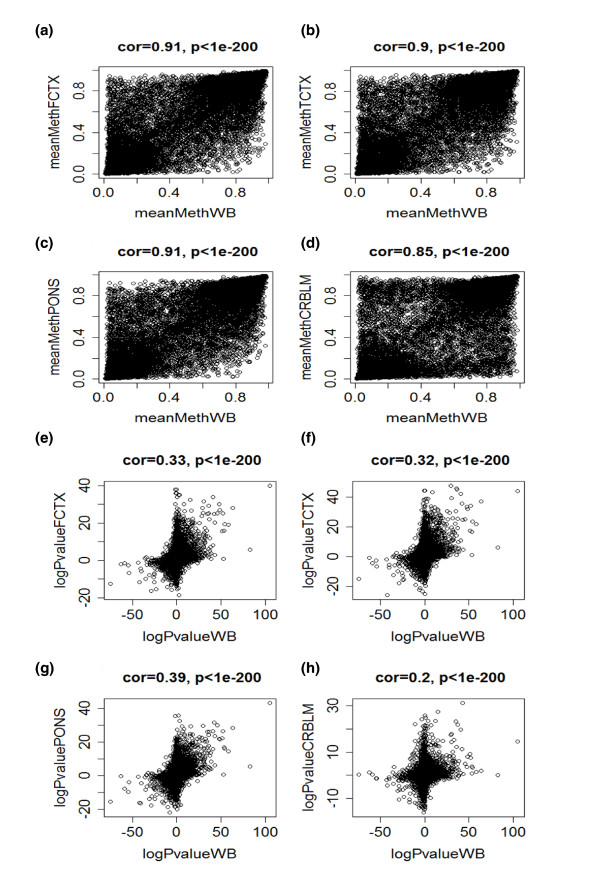
Age effects on DNA methylation levels are well preserved between blood and brain tissue. (a-d) Scatterplots of mean CpG methylation levels in whole blood of the Dutch samples (x-axis) and corresponding mean brain methylation values (y-axis) for frontal cortex (FCTX) (a), temporal cortex (TCTX) (b), pons (c), and cerebellum (CRBLM) (d). The brain methylation data used were obtained from [19]. Note that strong correlations (around r = 0.9) exist between the mean methylation levels in whole blood and brain tissue. We hypothesize that the relatively low correlation of r = 0.85 for cerebellum may reflect DNA quality. (e-g) Age correlations of CpG methylation levels show moderate preservation (correlations around 0.33) between blood (x-axis) and brain tissues (y axes). Analogous to Figure 1, the methylation levels of each gene (represented by a dot) were correlated with subject age and a linear regression model was used to calculate a correlation test P-value. The x-axis of each scatterplot shows the (signed) logarithm (base 10) of the correlation test P-value in blood. Genes with a significant positive (negative) correlation with age have a high positive (negative) log P-value. The y-axis shows the corresponding correlation test P-values in the frontal cortex (e), temporal cortex (f), pons (g), and cerebellum (h).